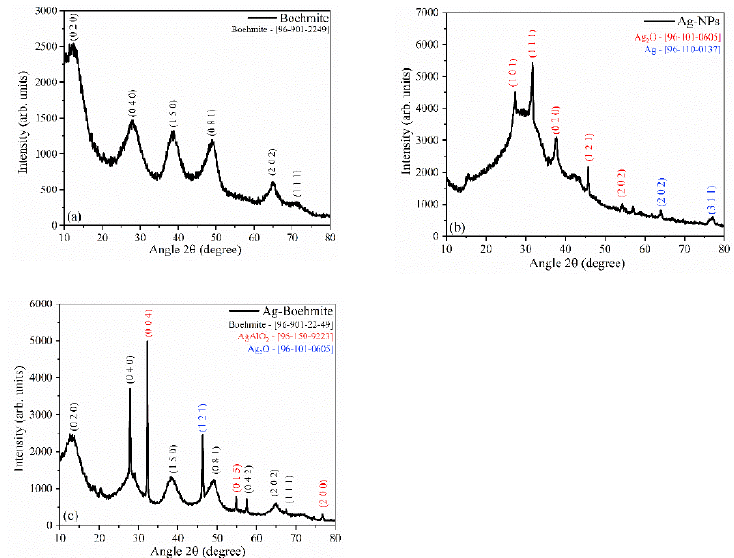
Figure 5. X-ray diffractograms of the samples: ( a ) boehmite; ( b ) Ag-NPs, and ( c ) Ag-Boehmite. The samples in powder form were placed directly in an appropriate sample holder for XRD analysis, scanning with an increment of 0.07 ◦ /s between 10 ◦ and 80 ◦ 2 theta.